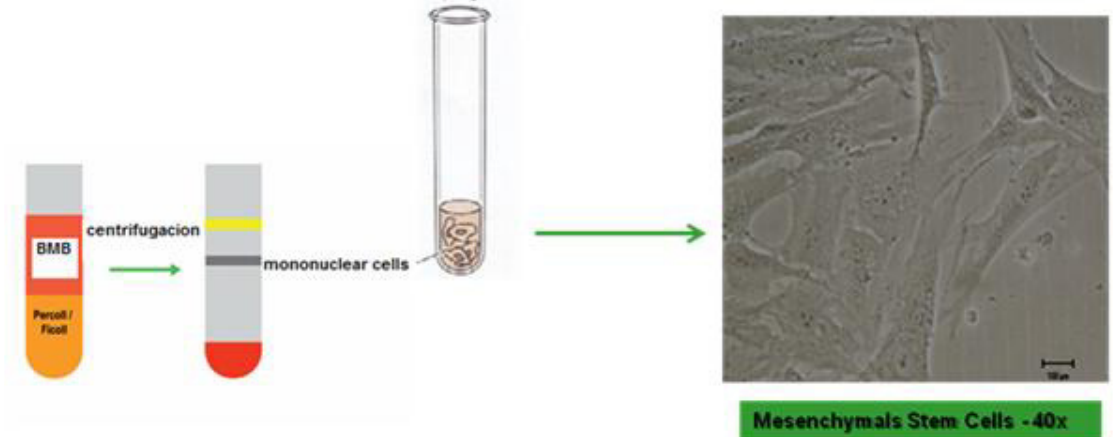
FIGURE 3 - Colorless mononuclear cell layer